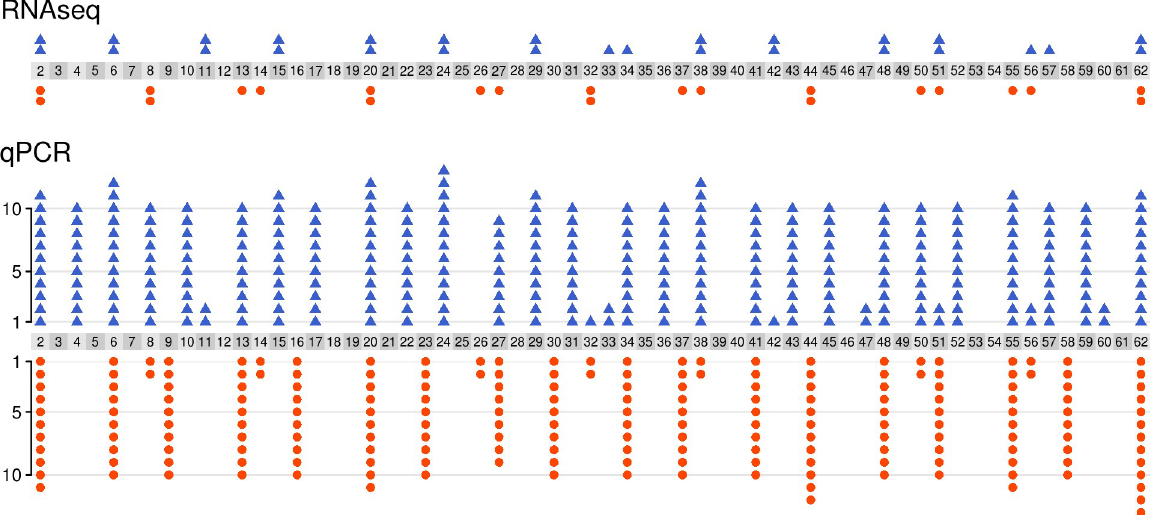
Fig 1. Number of samples used for RNAseq (top; total = 50) and qPCR (bottom; total = 498), split by age category (2–62 days old). Individual female and male flies shown as blue triangles and orange circles